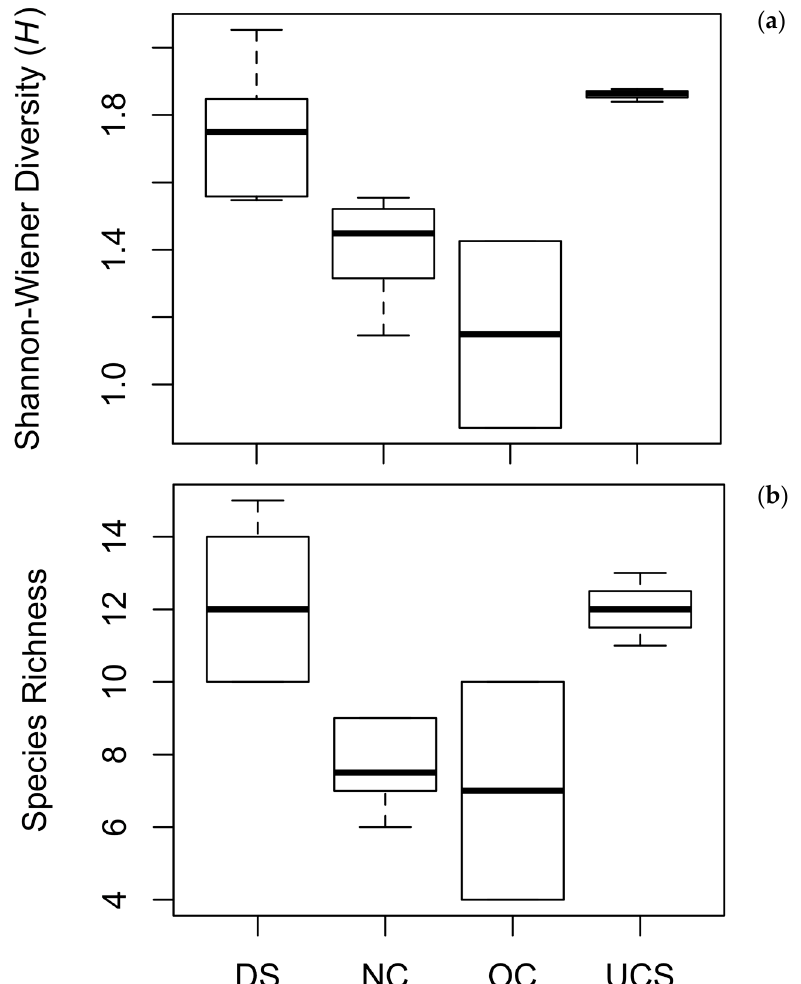
Figure 3. Box plots of ( a ) Shannon-Wiener diversity and ( b ) species richness across the four channel types, where DS are sites downstream of the newly reconfigured channel, NC are new channel sites, OC are old channel sites, and UCS is the upstream control site. Bold lines indicate median, boxes represent interquartile range, and the whiskers are 1.5 times the interquartile range. RDA axes 1, 2, and 3 were statistically significant and explained 49.7%, 27.6%, and 11.9% of the